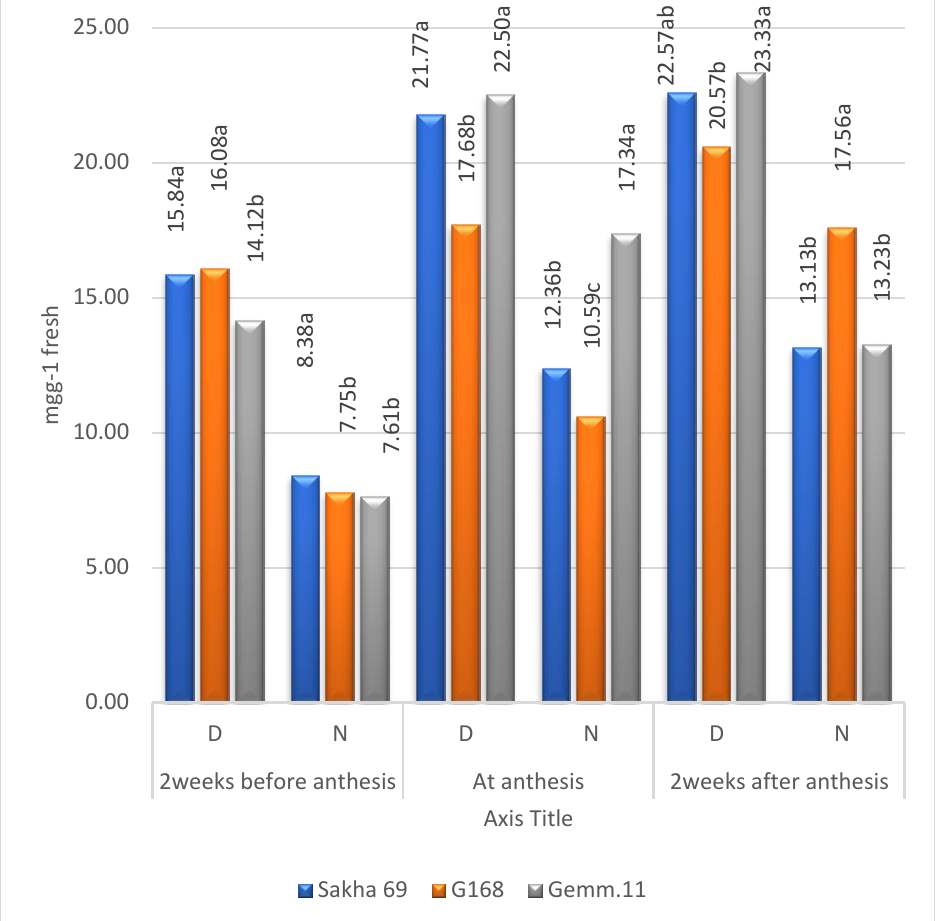
Figure 4. Combined means of soluble sugar for cultivars under drought stress (D) and irrigation (N); means followed by the same letter in each environment are not significant at the 0.05 level of probability according to LSD test.